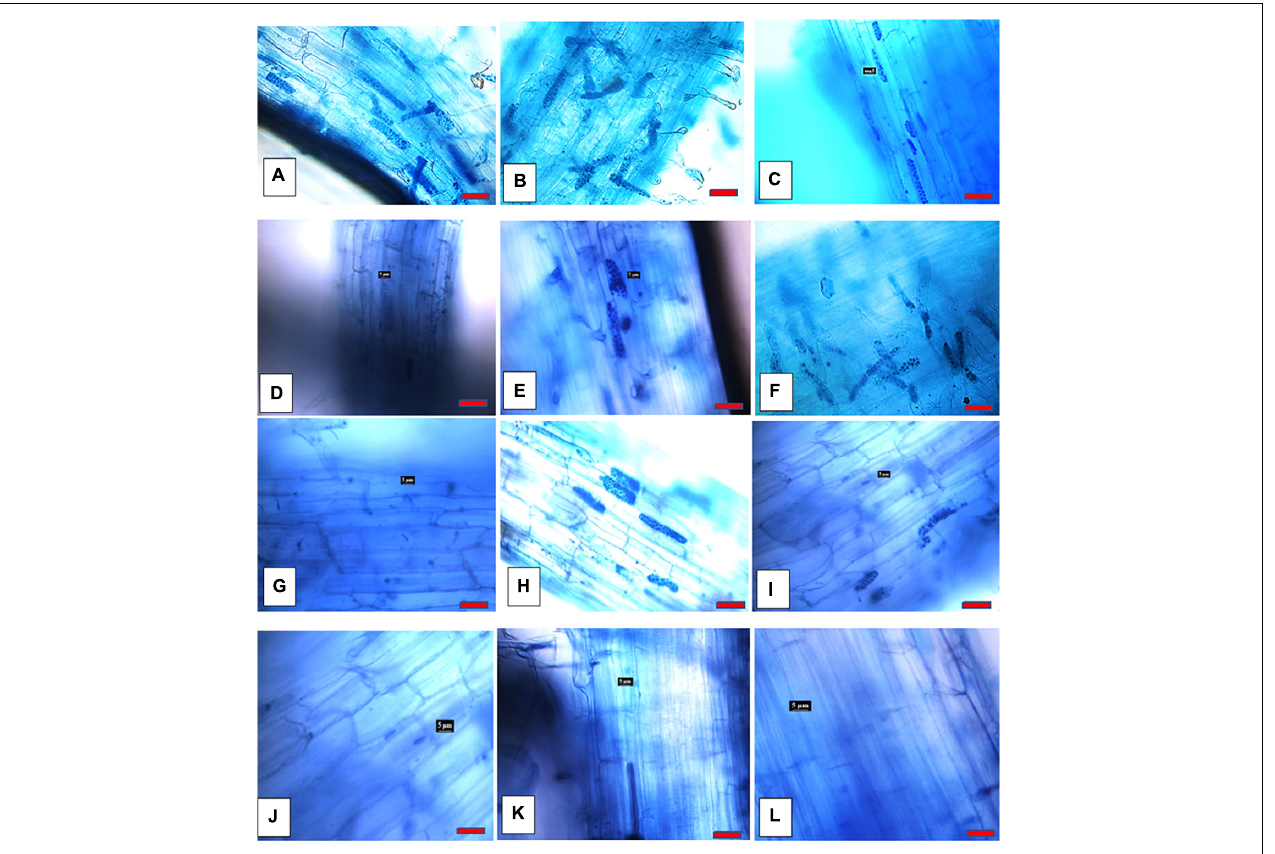
FIGURE 3 | Spongospora subterranea zoosporangia root infection in potato (cv. Iwa) root 8 weeks following incubation with zoospore inoculum: (A) without Ca 2 + antagonists; (B) 100 µ M EGTA; (C) 500 µ M EGTA; (D) 1 mM EGTA; (E) 100 µ M amiloride hydrochloride; (F) 150 µ M amiloride hydrochloride; (G) 200 amiloride hydrochloride; (H) 2 µ M TPF; (I) 3.5 µ M TPF; (J) 5 µ M TFP; (K) 50 µ M LaCl 3 ; and (L) 50 µ M GdCl 3 (scale bar = 20 µ m; magnification